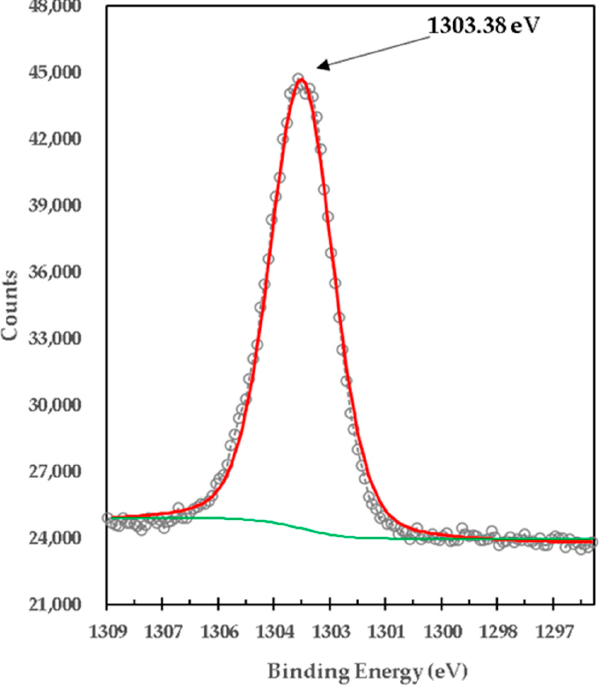
Figure 8. XPS high resolution spectra of Mg1s in brucite M4.